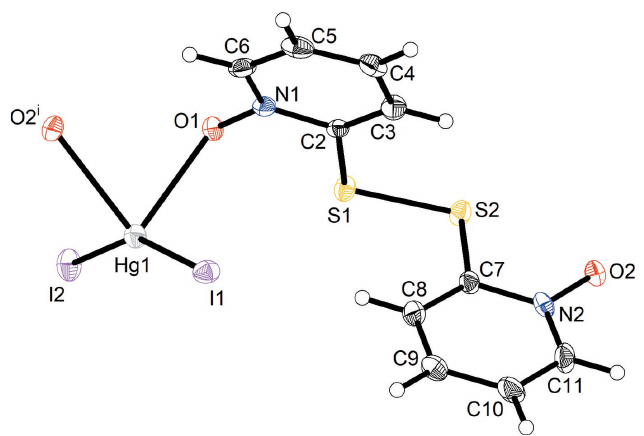
Figure 1 Displacement ellipsoid plot (50% probability level) of the title compound, showing the repeat unit of the coordination polymer and the coordination sphere of Hg II . H atoms are represented by small spheres of arbitrary radii. [Symmetry code: (i) (cid:4) x + 3